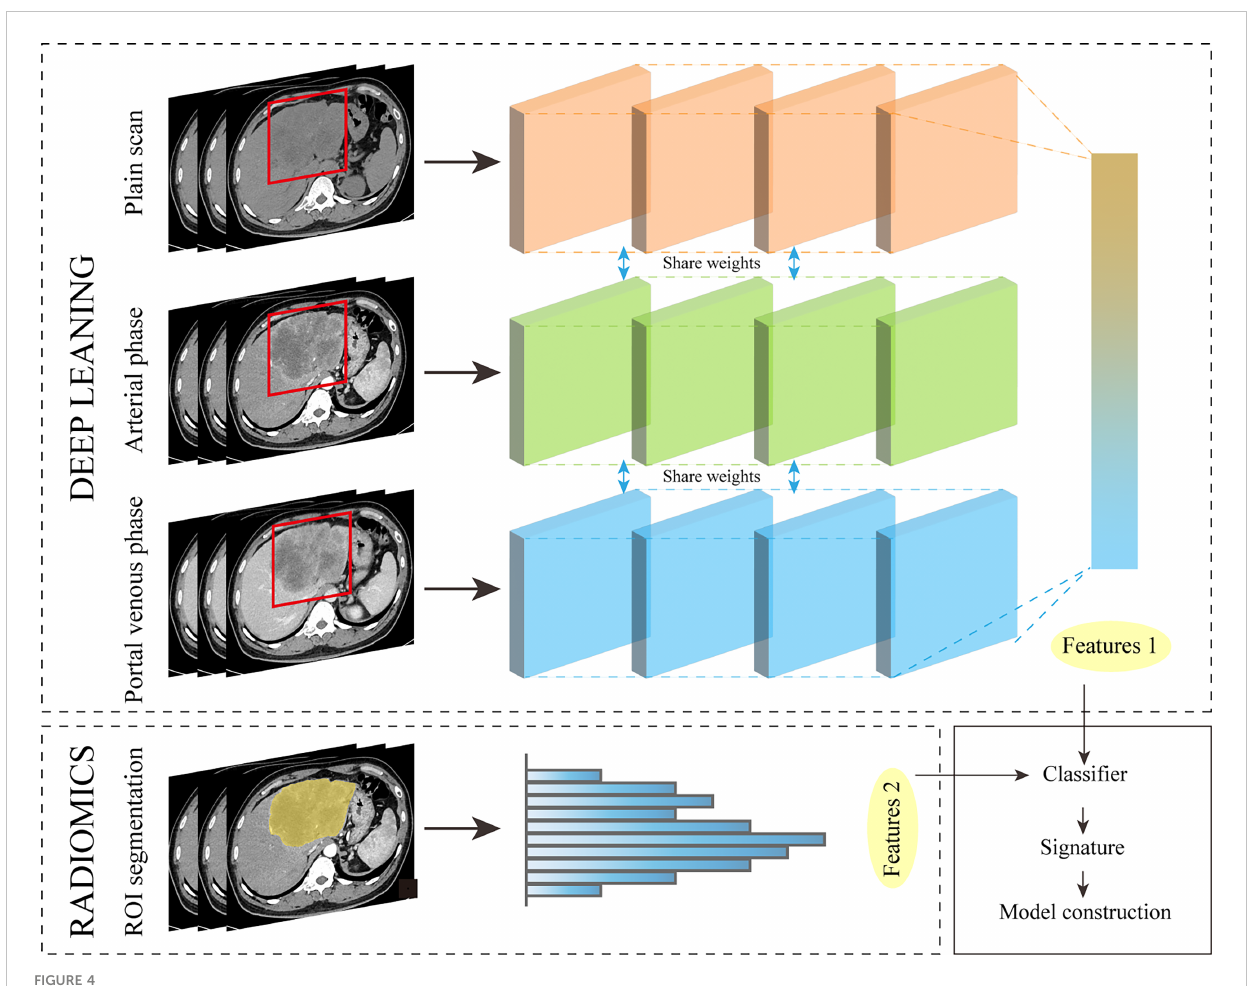
FIGURE 4 Work fl ow of deep learning for feature